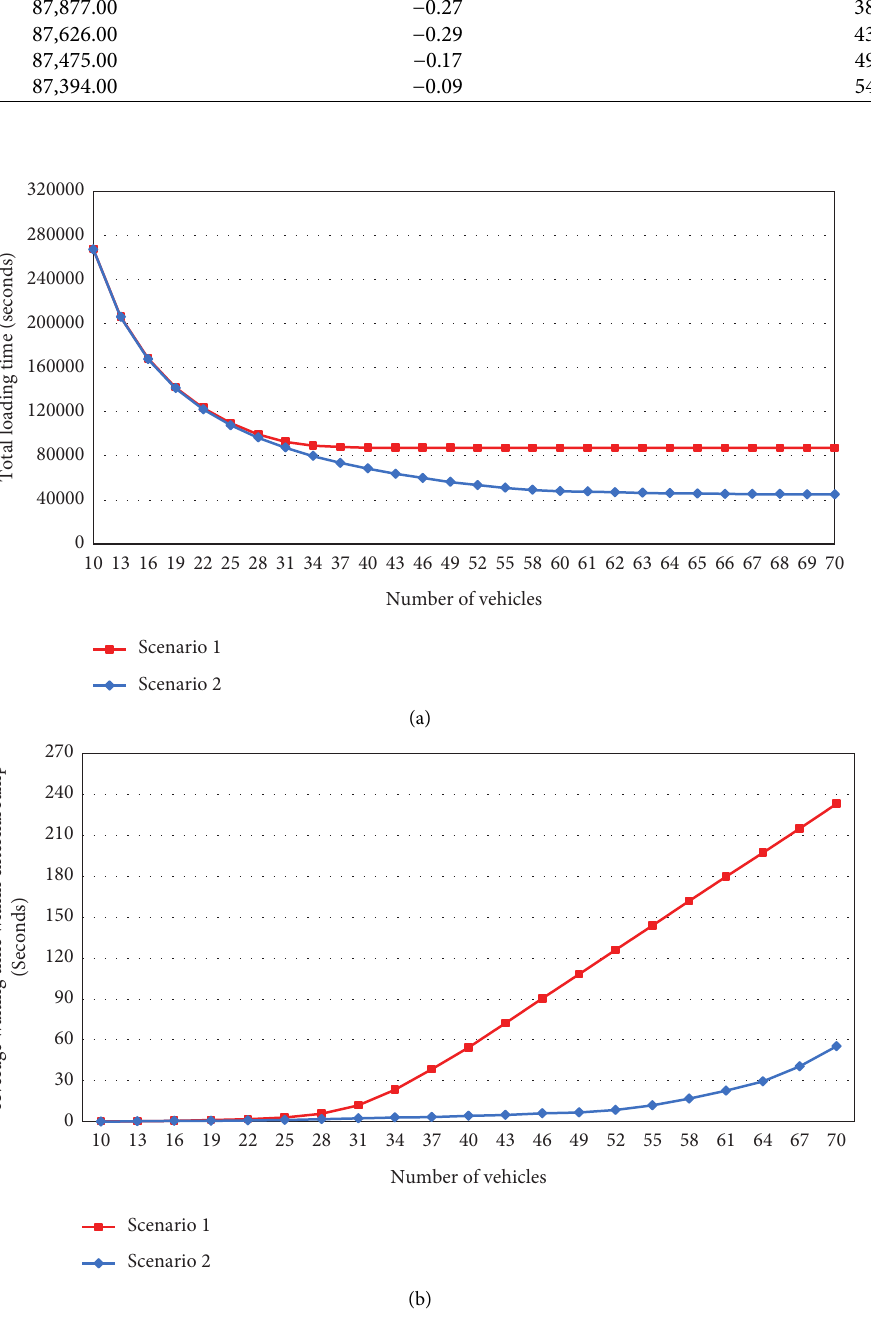
Figure 5: AGV loading system scenarios 1 and 2: (a) total loading time and (b) average waiting time within the external ramp. The difference between scenarios increased with the number of AGVs (source: